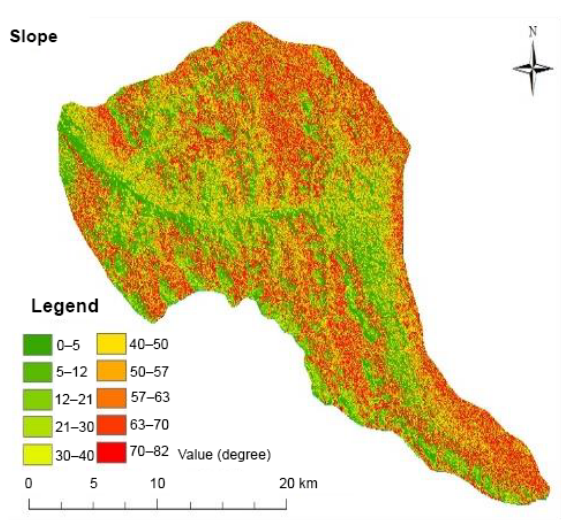
Figure 5. Slope morphology of the basin.